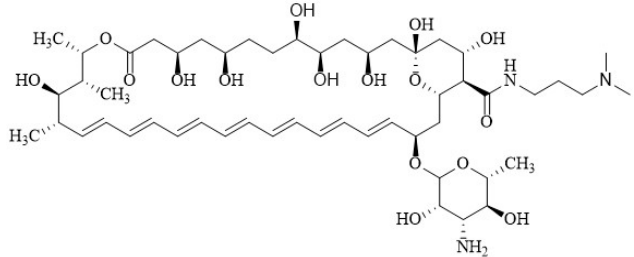
Figure 9. The amide N , N -dialkyl derivative 6 .